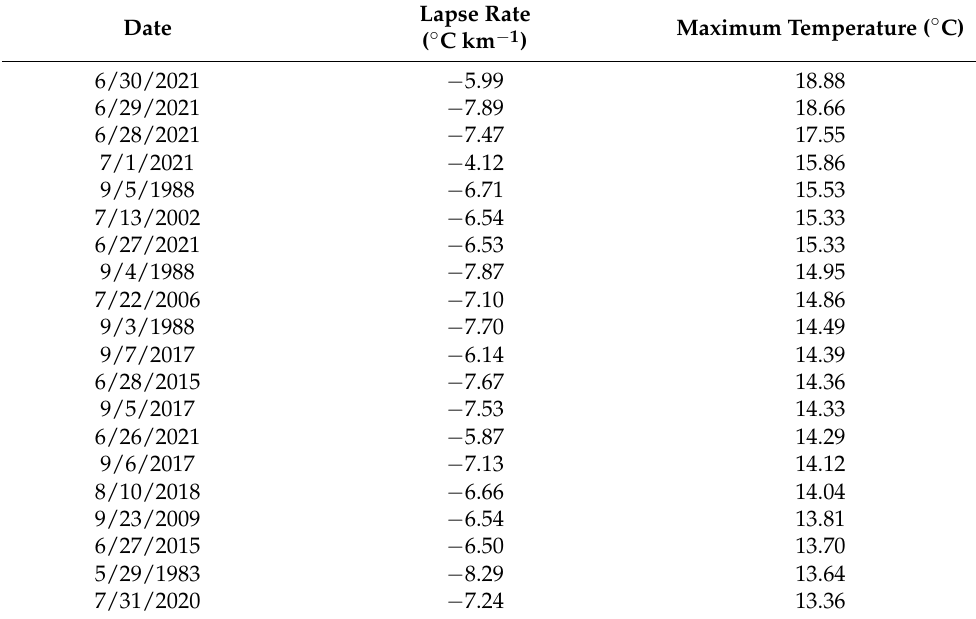
Table 4. The twenty highest maximum summer days with the highest maximum temperature at 3000 m from the ERA5 reconstruction for Mount Baker, Washington for May 1979 to July 2021. The lapse rate ( ◦ C km − 1 ) is also